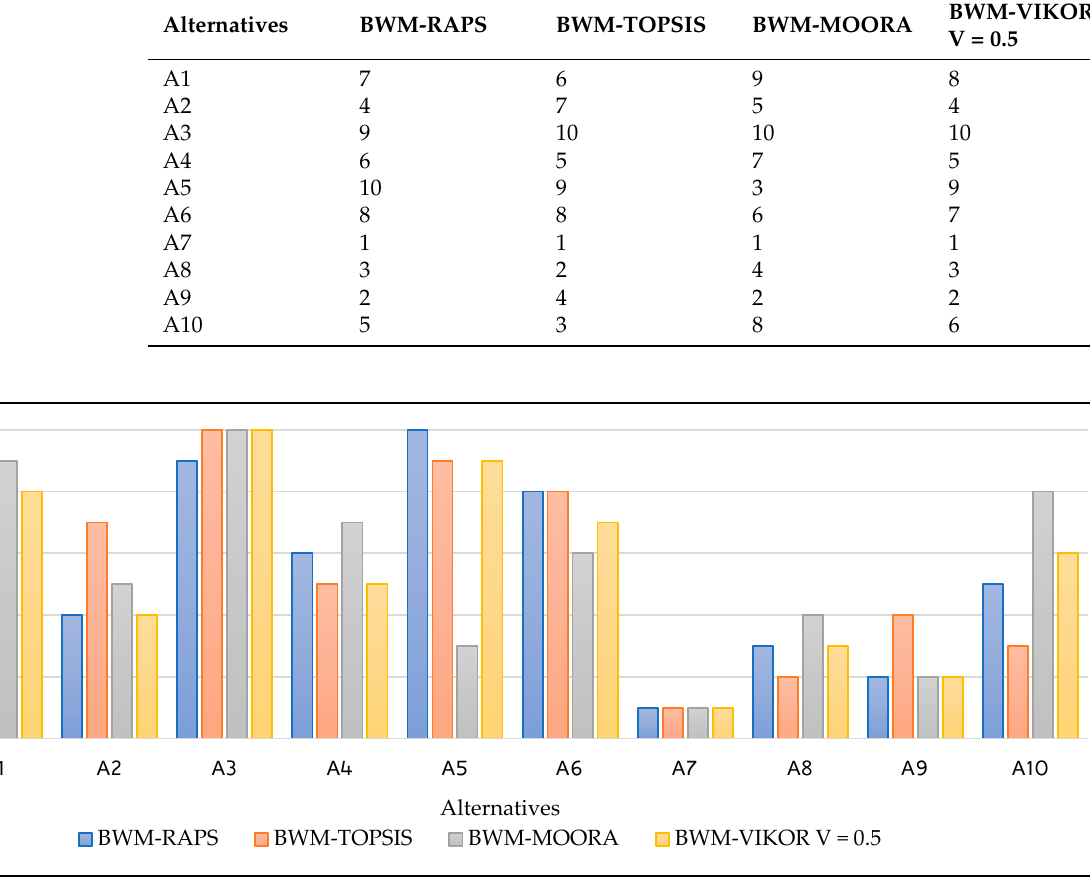
Figure 3. Bar chart representation of rankings obtained under comparative analysis.